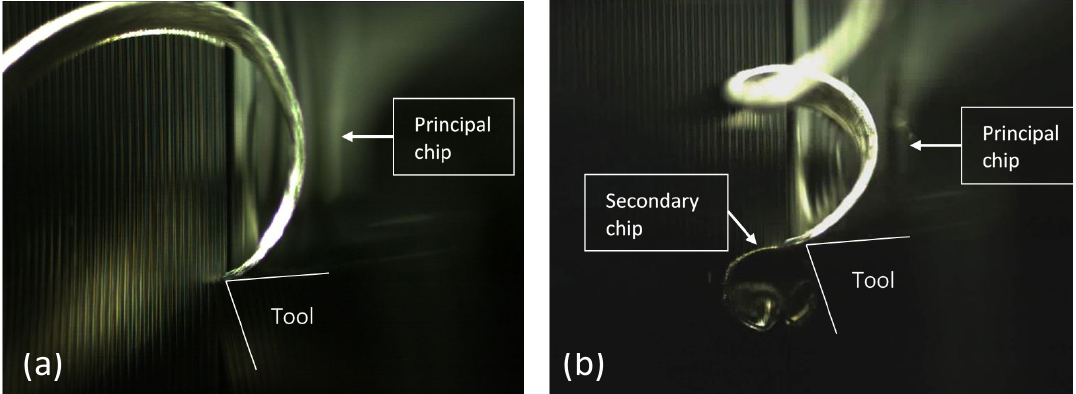
Figure 10. Picture taken with the high-speed camera during a test with the Seco PCBN tool at a cutting speed of 300 m/min, a feed 0.15 of mm/rev, and a depth of pass of 0.15 mm: ( a ) in the first instance of use; ( b ) after the presence of a significant notch in the tool.